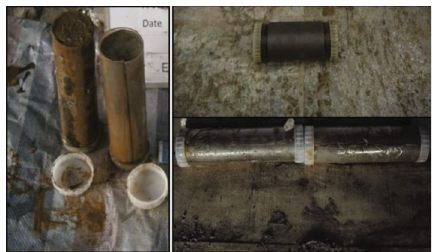
Figure 1: Sampling diagram of undisturbed soil sample on-site.